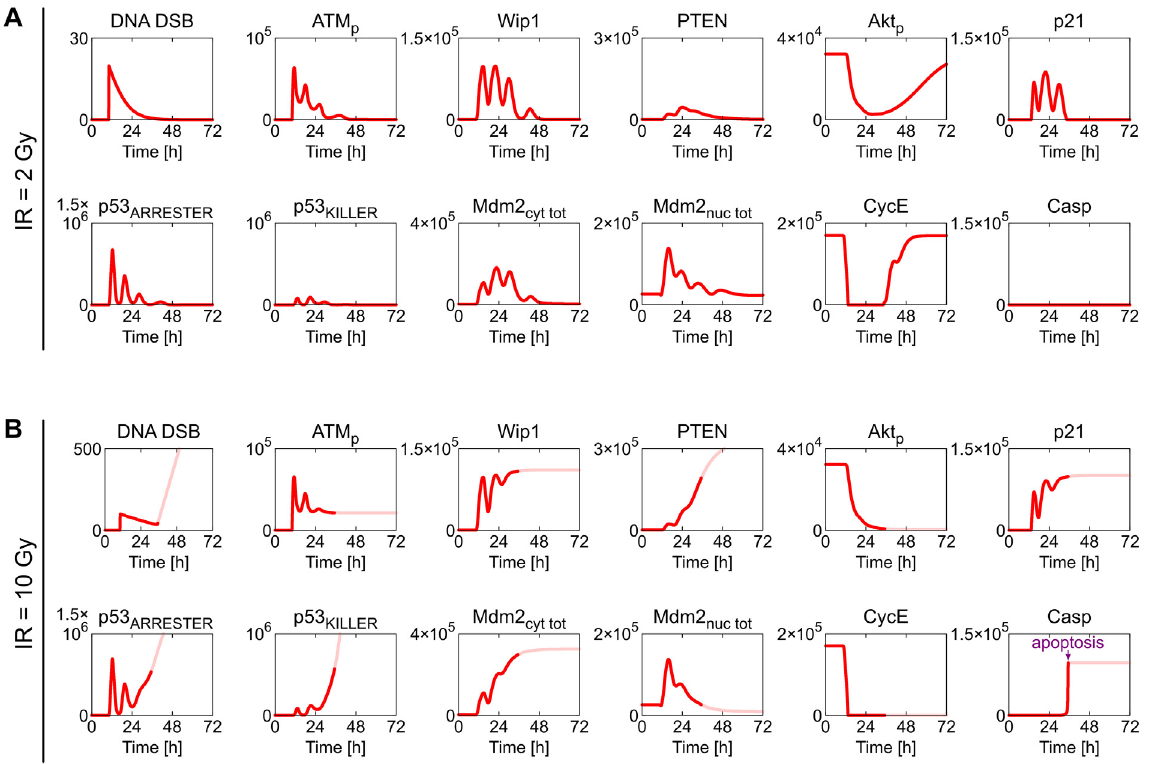
Fig 7. Deterministic simulation trajectories of the intact system in response to 2-Gy and 10-Gy irradiation. (A) 2-Gy irradiation is insufficient to trigger apoptosis and after several oscillations system recovers to the survival steady state. (B) 10-Gy irradiation is sufficient to trigger apoptosis: after two oscillations p53 KILLER stabilizes at a high level triggering